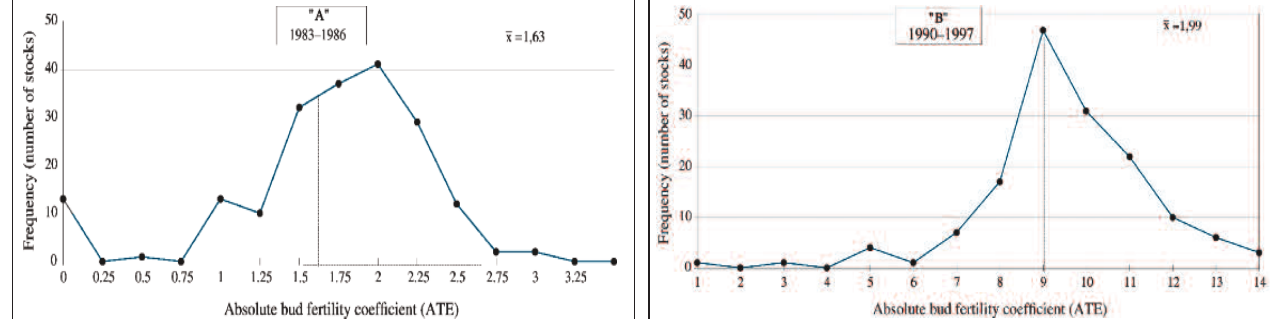
Fig. 16. Frequency distribution of mother stocks according to their bud fertility Muscat